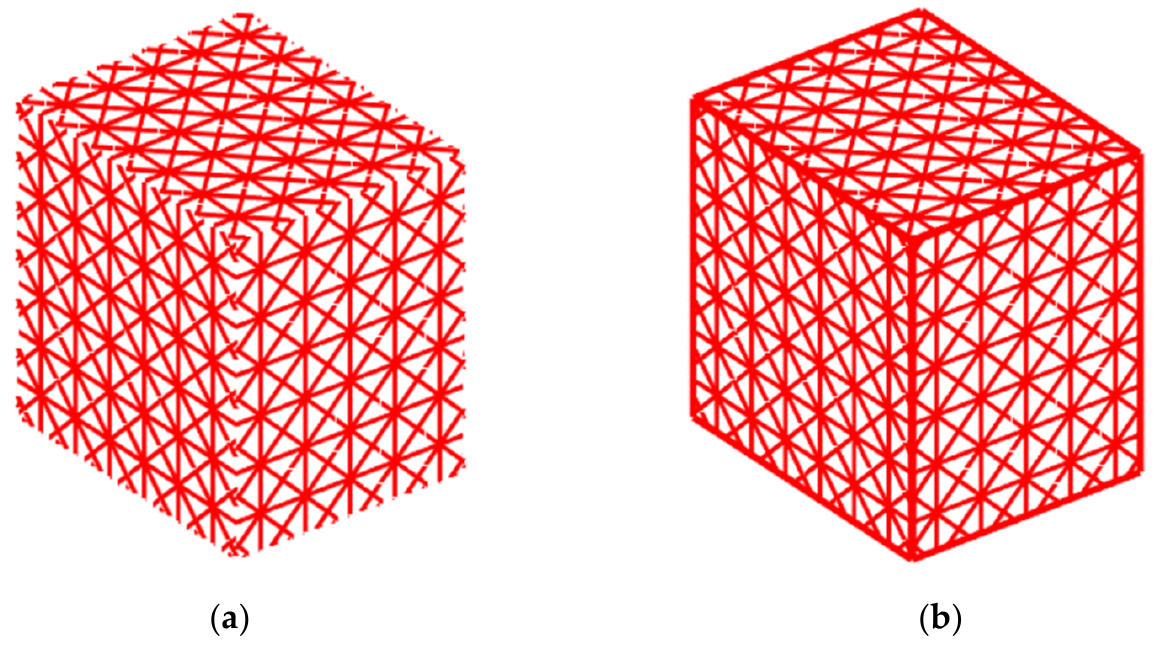
Figure 11. ( a ) Lattice net without preserved features ( b ) Lattice net with preserved features.